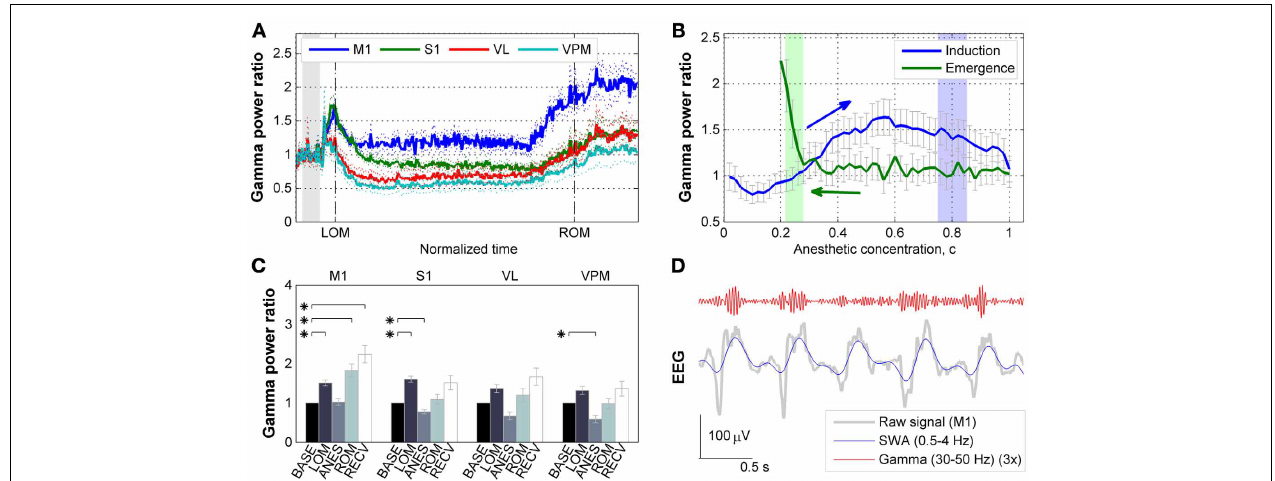
corresponding concentrations of 0 . 80 ± 0 . 05 and 0 . 25 ± 0 . 03, respectively. (C) Change of gamma power at different brain regions for different behavioral states. Error bars indicate s.e.m. Asterisks indicate significant ( p < 0 . 05, Friedman’s ANOVA test and post-hoc Wilcoxon signed rank test with Bonferroni correction) difference from baseline. (D) Gamma oscillation superimposed on slow (0.5–4Hz) oscillation during anesthesia. Gamma oscillation is exaggerated for the sake of clarity. BASE, baseline; LOM, loss of motion; ANES, anesthesia; ROM, recovery of motion; RECV, recovered state; M1, primary motor cortex; S1, primary somatosensory cortex; VL, ventral lateral thalamic nucleus; VPM, ventral posteromedial thalamic